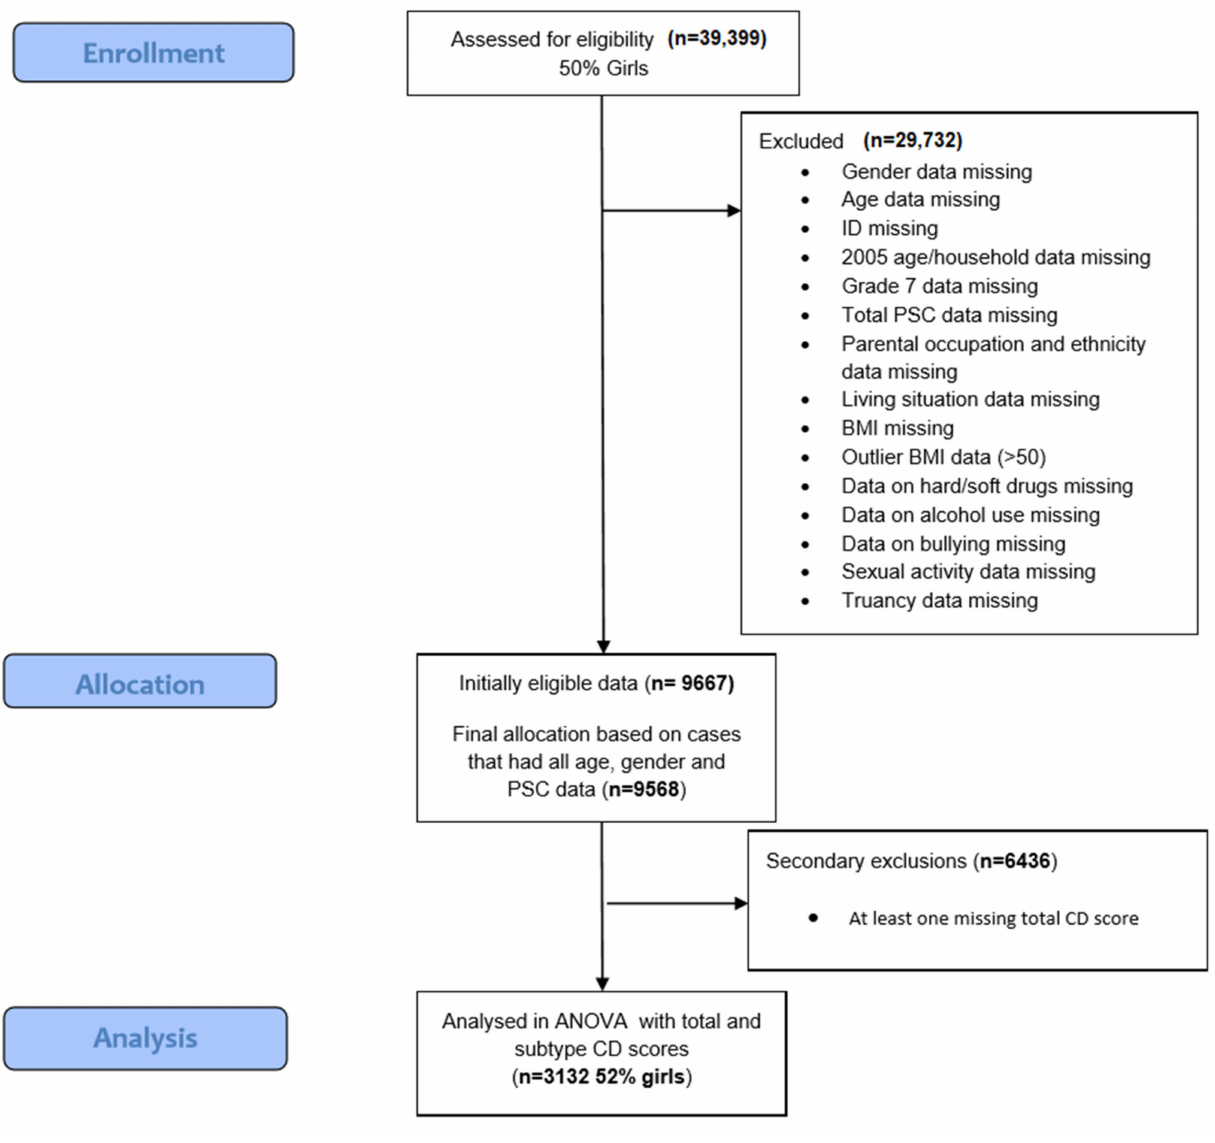
Figure 1. PRISMA diagram to describe participant enrollment, allocation and data